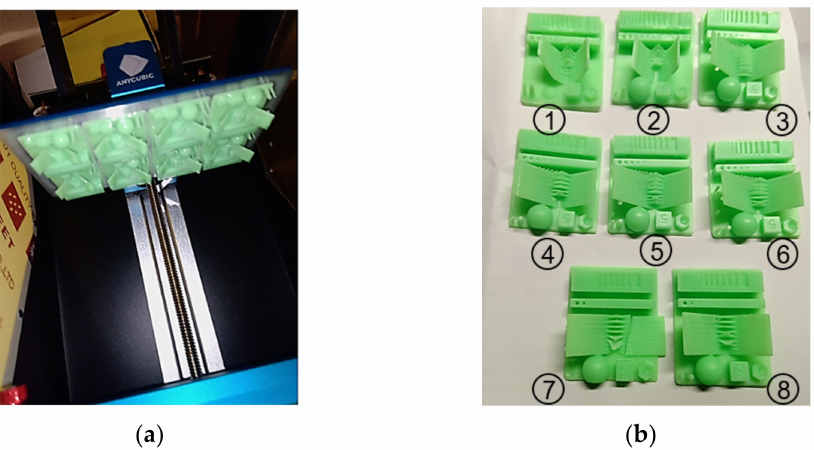
Figure 4. ANYCUBIC 3D printer and exposure time test: ( a ) Platform on Z -axis top position with eight simultaneously printed parts; ( b ) Positions on the printed parts platform.